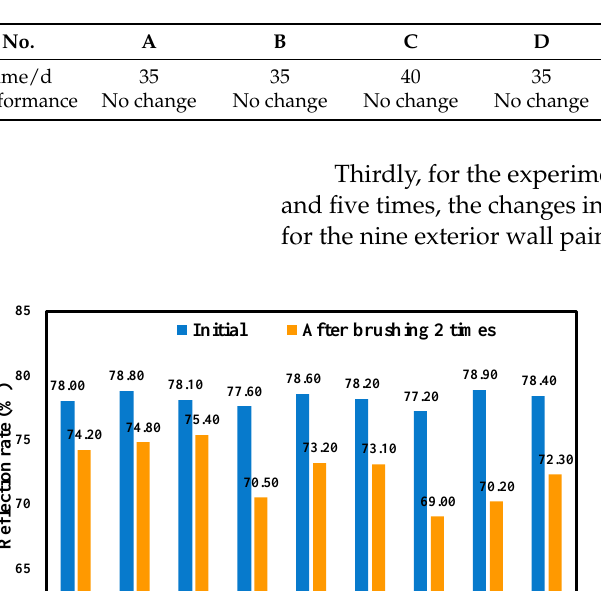
Table 11. Results for Design 1 (alkali resistance).